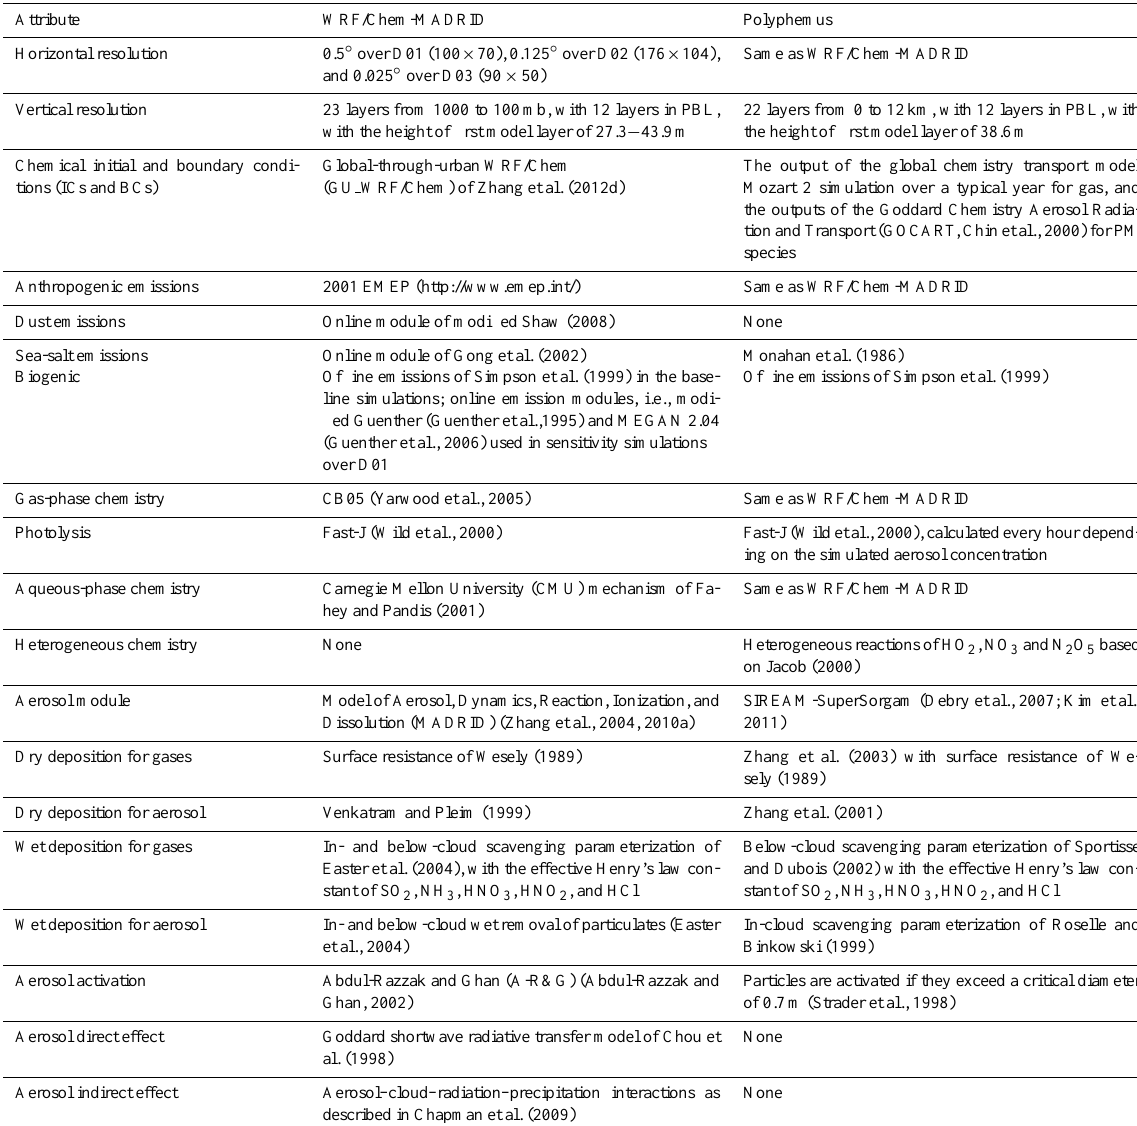
Table 1. Model configurations and major atmospheric process treatments in WRF/Chem and Polyphemus.